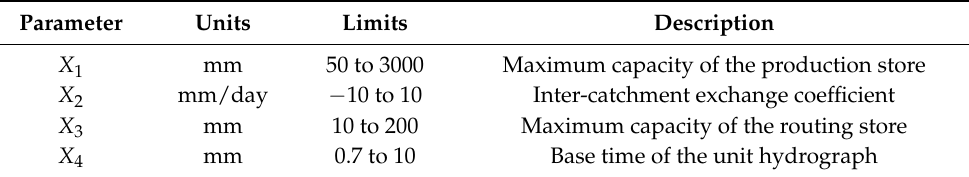
Table 3. Description of main parameters of GR4J model.